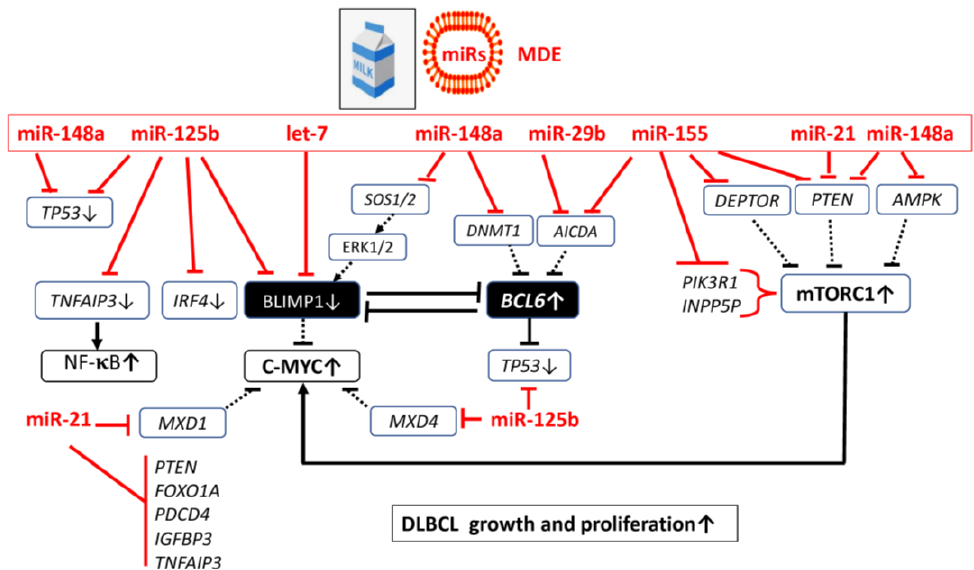
Figure 2. Illustrated mechanistic role of bovine milk-derived exosomes (MDE) and their microRNAs (miRs) in epigenetic signaling in diffuse large B-cell lymphoma (DLBCL). The key oncogene upregulated in most DLBCL is B cell lymphoma 6 (BCL6) activating the germinal center reaction and promoting B cell proliferation. The expression BCL6 is suppressed by a complex of DNA methyl- transferase 1 (DNMT1) and activation-induced cytidine deaminase (encoded on AICDA ), which catalyzes BCL6 promoter methylation. DNMT1 is a target of miR-148a, the most abundant miR of human and bovine milk and their MDEs. AICDA is targeted via miR-155 and miR-29b, abundant immune-regulatory miRs of human and bovine milk. MDE miRs may thus enhance BCL6 expression promoting B cell proliferation. BCL6 is a critical inhibitor of B lymphocyte-induced maturation protein 1 (BLIMP1, encoded on PRDM1 ), the key driver of B cell differentiation. miR-148a via suppression of SOS RAS/RAC guanine nucleotide exchange factor 1 and 2 (SOS1/2) inhibits ERK1/2-mediated expression of BLIMP1. Thus, miR-148a indirectly increases the ratio of BCL6/BLIMP1. BLIMP1 is directly suppressed via the let-7 family of miRs and miR-125b, further abundant miRs of human and bovine milk and their MDEs. Reduced expression of BLIMP1 enhances C-MYC expression, a key oncogene driving cell proliferation. C-MYC translation is dependent on the mechanistic target of rapamycin complex 1 (mTORC1). Negative regulators of mTORC1 are DEP domain-containing protein 6 (DEPTOR encoded on DEPDC6 ), phosphatase and tensin homolog (PTEN), and AMP-activated protein kinase (AMPK), which are targeted via abundant miR-155, miR-21 an miR-148a, respectively. In addition, miR-21 targets MAX dimerization protein 1 ( MXD1 ), whereas miR-125b targets MAX dimerization protein 4 ( MXD4) , leading to sustained C-MYC activation. In addition, miR-148a and miR-125b target TP53, the key transcription factor of a multitude of tumor suppressor genes. miR-125b also targets interferon regulatory factor 4 (IRF4), a well-defined transcription factor obligatory required for the terminal differentiation of B cells to plasma cells. A further target of miR-125b is tumor necrosis factor alpha-induced protein 3 ( TNFAIP3 ), also known as A20. TNFAIP3 is a negative regulator of nu- clear factor kappa B (NF- κ B) signaling, which is upregulated in most cases of DLBCL. Notably, miR-21 also targets TNFAIP3 as well as forkhead box O A1 ( FOXO1A ), programmed cell death 4 ( PDCD4 ), and insulin-like growth factor-binding protein 3 ( IGFBP3 ). Thus, the most abundant milk-derived miRs maintain mTORC1 activation, and promote the expression of BCL6 and NF- κ B, but suppress cell cycle inhibitor p53 and transcription factors BLIMP1 and IRF4 involved in B cell differentiation and plasma cell and antibody formation. This signaling scenario may be useful for neonatal B cell proliferation during the period of lactation when high-affinity antibodies educated by the maternal immune system are provided to the infant via breastfeeding. However, persistent epigenetic milk miR signaling via continued exposure to bovine MDE-transferred miRs provided by the consumption of pasteurized cow’s milk may promote BCL6/BLIMP1-dependent